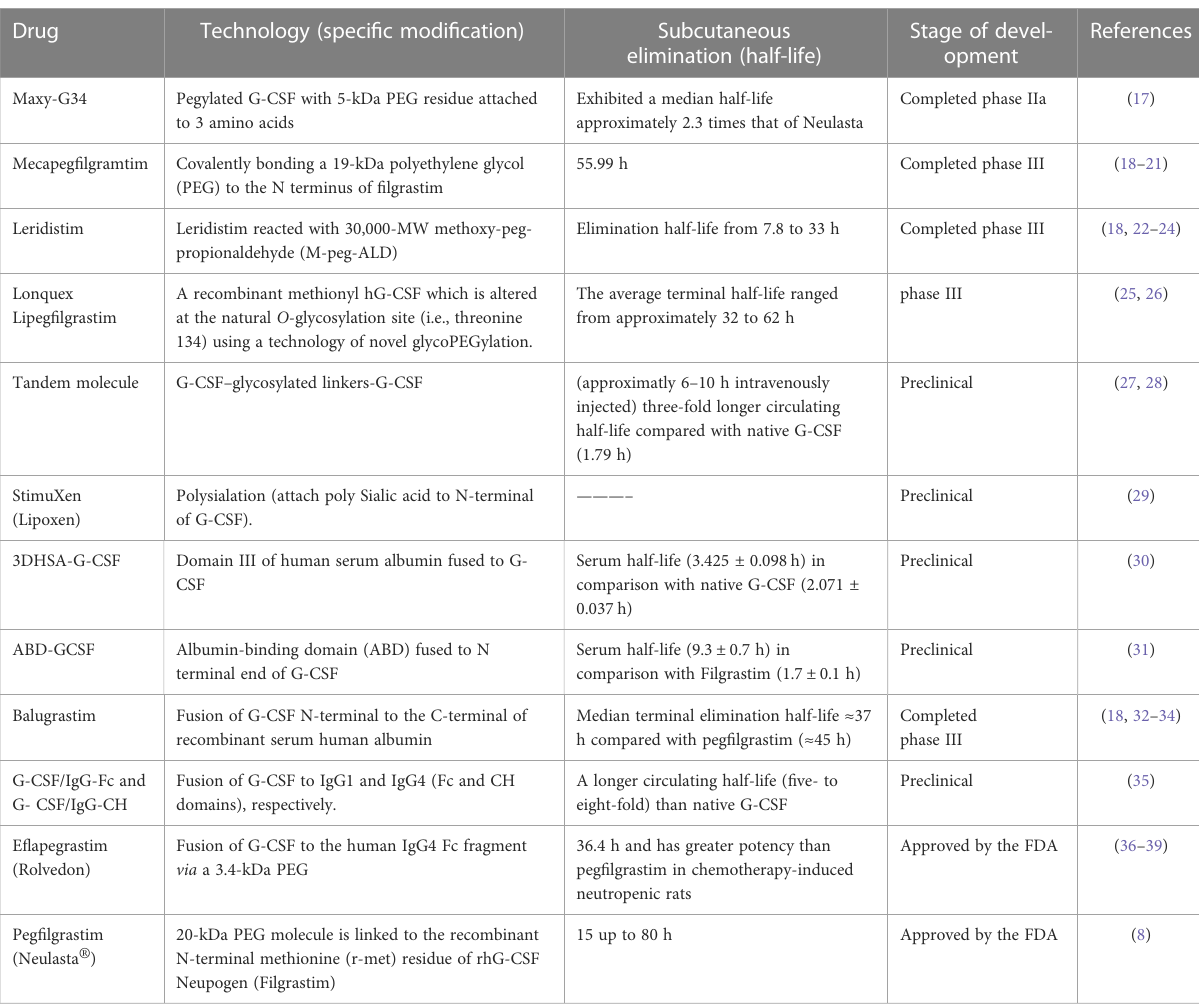
TABLE 1 Long-acting G-CSF formulations are considered for increasing the in vivo residence time of G-CSF compared with native G-CSF, fi lgrastim (rhG-CSF), and Neulasta. Drug